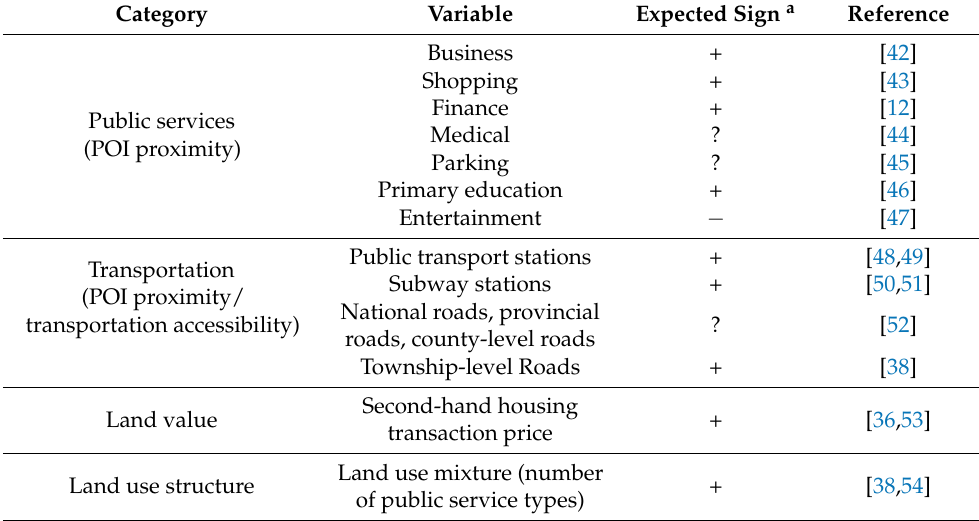
Table 1. Variable